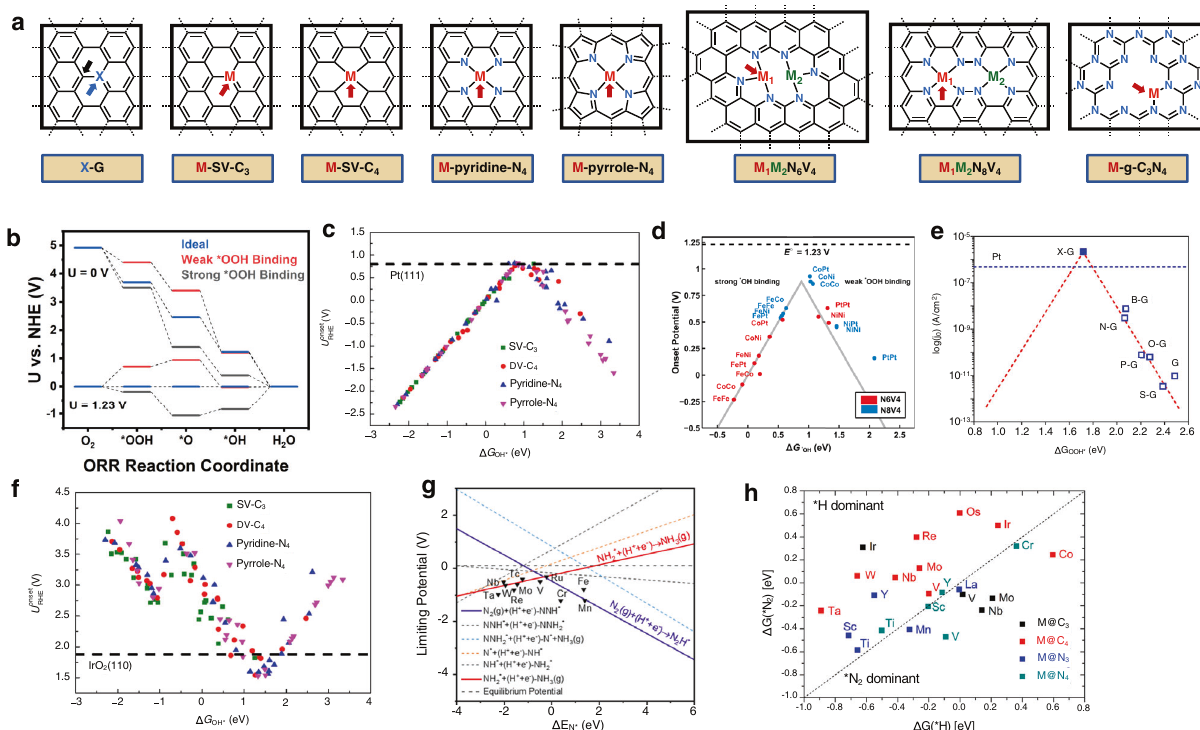
Fig. 6 Volcano relationships from EN computational studies. a EN cells which have been investigated in computational studies. b Thermodynamic plot which shows the free energy of each elemental step for ideal (blue) and non-ideal (red and gray) catalysts for the ORR at O and 1.23 V applied potential. ) versus OH adsorption free energies ( 4 G (cid:2) ). c , d ORR volcano plots for single-SACs and bimetallic-SACs, showing the theoretical onset potentials ( U onset RHE OH Adapted and reprinted with permission from refs. 108,109 . e ORR volcano plot for MGEN constructed from plotting the theoretical exchange current density ( j theory ) versus free energies of OOH adsorption ( 4 G (cid:2) ). Adapted and reprinted with permission from ref. 110 , https://pubs.acs.org/doi/10.1021/ 0 OOH ja500432h, all future permissions should be directed to the ACS. f OER volcano plot for single-metallic SACs, showing the theoretical onset potentials ( U onset ) versus OH adsorption free energy ( 4 G (cid:2) ). Adapted and reprinted with permission from ref. 108 . g NRR volcano plot for C 3 N 4 SACs constructed RHE OH from plotting theoretical limiting potentials versus free energy of N adsorption ( 4 G (cid:2) ). Adapted and reprinted with permission from ref. 111 . h Selectivity N plot for the NRR vs. HER for SACs constructed by plotting free energy of N adsorption ( 4 G (cid:2) ) versus free energy of H adsorption ( 4 G (cid:2) ). Adapted and N H reprinted with permission from ref. 112